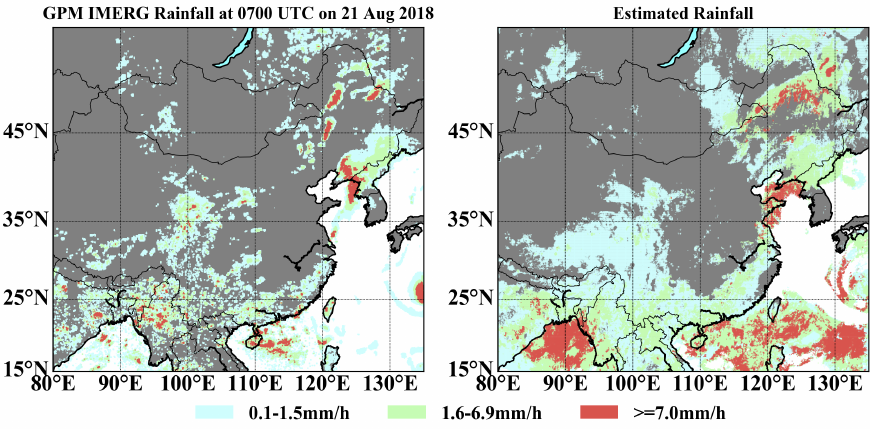
Figure 16. Comparisons of the rainfall retrieval integrated model between the GPM ( left ) and RF model ( right ) at 0700 UTC 21 August 2018.